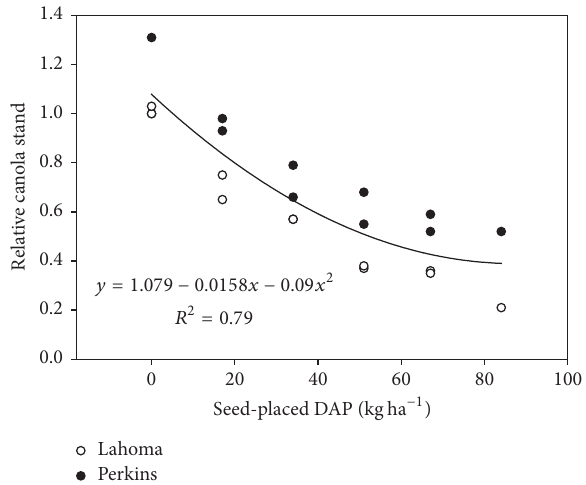
Figure 1: Canola stand relative to the untreated check as influenced by rate of seed-placed diammonium phosphate (DAP). Relative canola stand includes data from Lahoma and Perkins, OK, 2011–